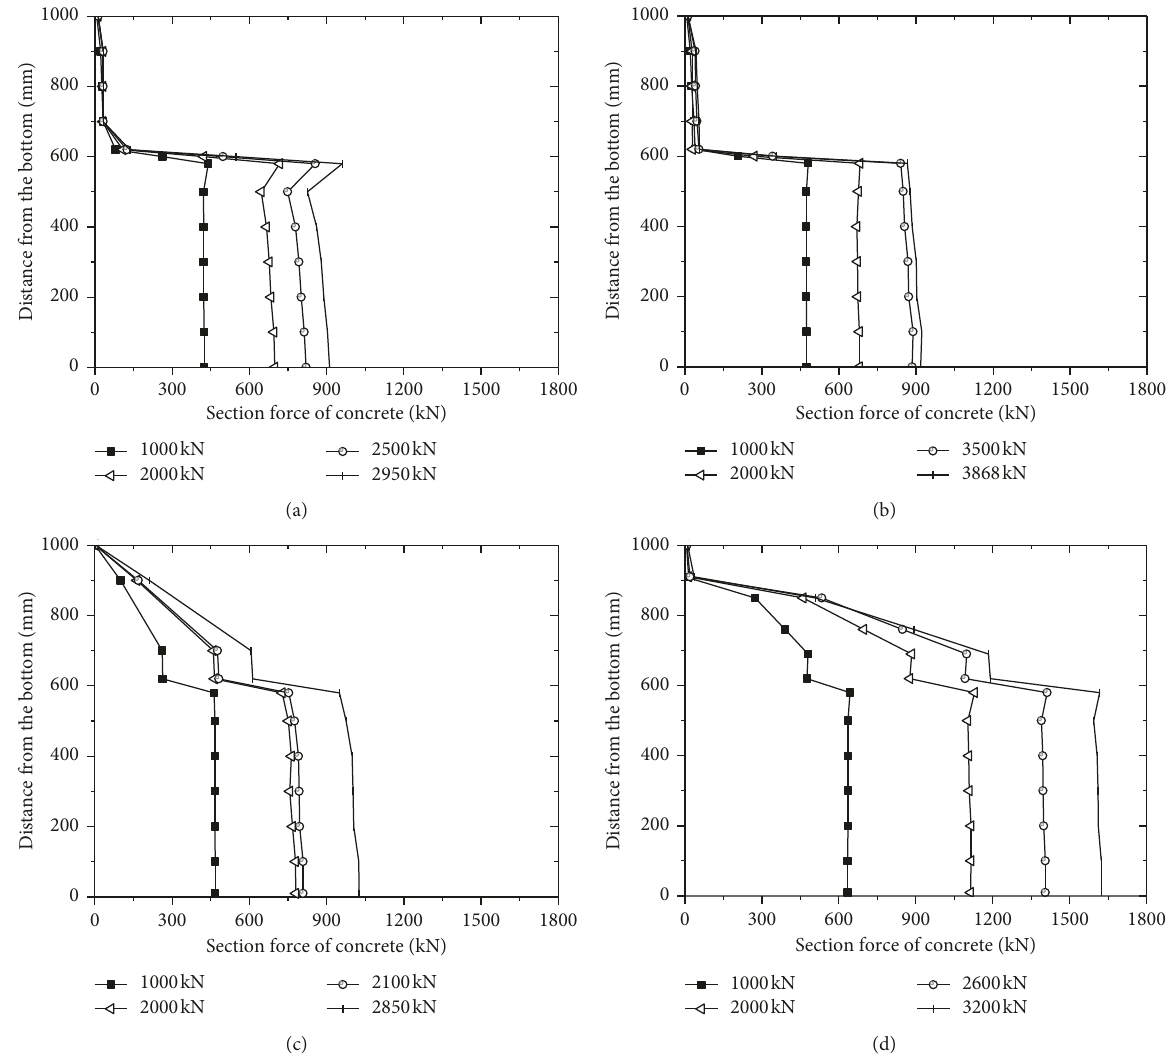
Figure 14: Concrete height-axial force variation curve: (a) SJ-1; (b) SJ-2; (c) SJ-3; (d)